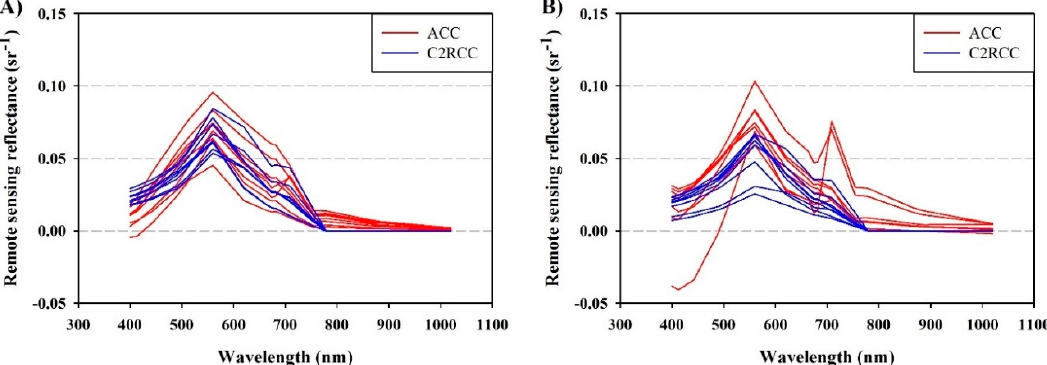
Figure 2. R rs spectra extracted from sampling points from GLERL in the Western region of Lake Erie, U.S.A. ( A ) R rs spectra from 22 August 2016 image; (B) R rs spectra from 13 September 2016